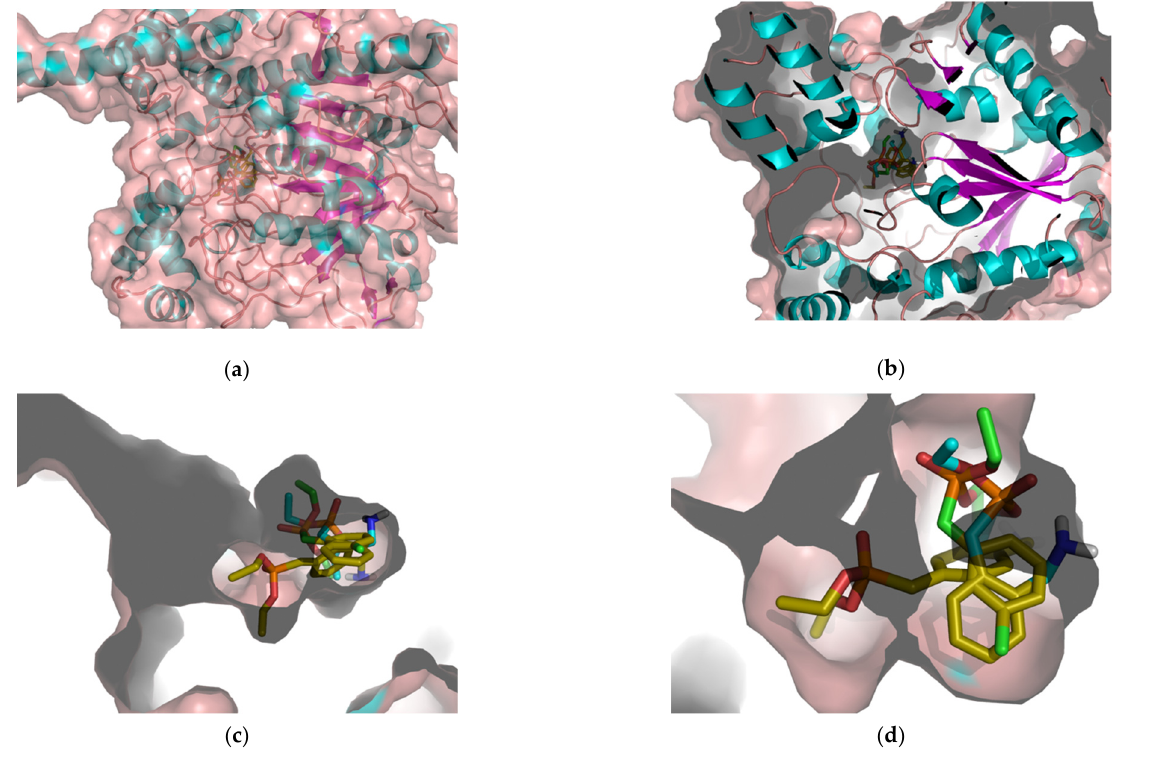
Figure 6. ( a – d ) The structure of electric eel AChE with the three ligands 8a – c . ( a ) The overall structure of the protein with secondary structure projection and protein surface; ( b ) the protein projection with all three compounds, 8a – c ; ( c , d ) the active side of the eeAChE with three